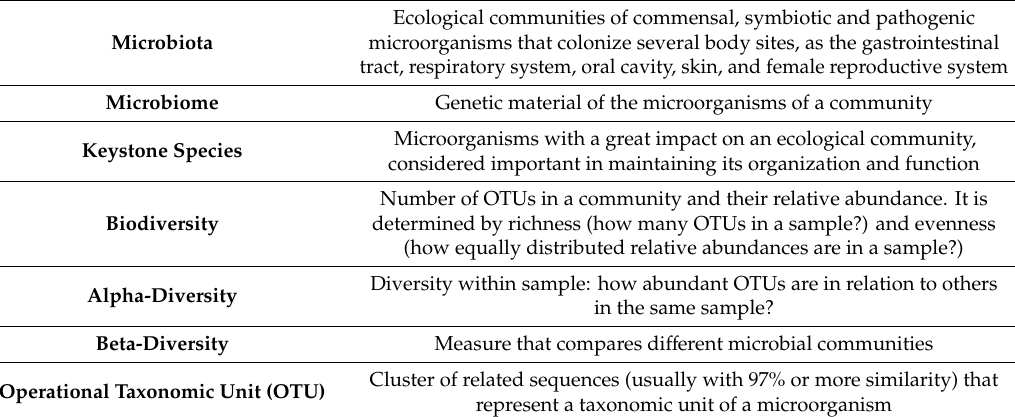
Table 1. Definitions of common terms used in microbiota investigations.